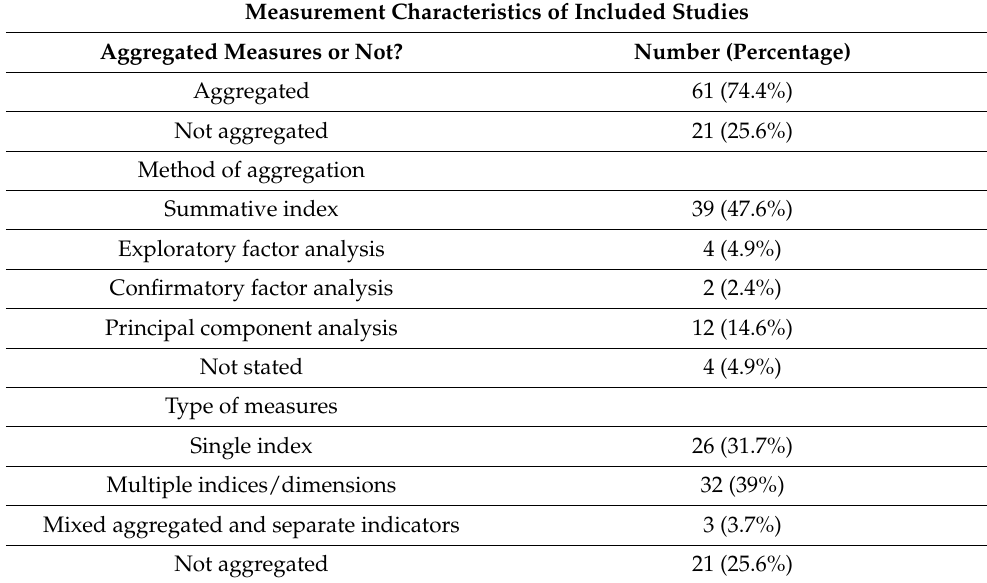
Table 5. Characteristics of scales used to measure women’s agency in included studies. Measurement Characteristics of Included Studies Aggregated Measures or Not? Number